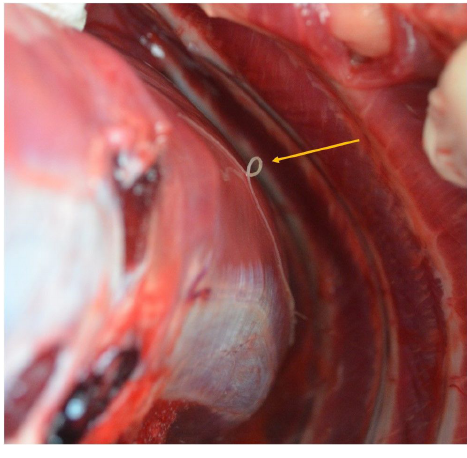
→ Worm free in the cavity. Figure 4. Postmortem examination of the dog which died due to heartworm infection showing a free worm in the thoracic cavity.